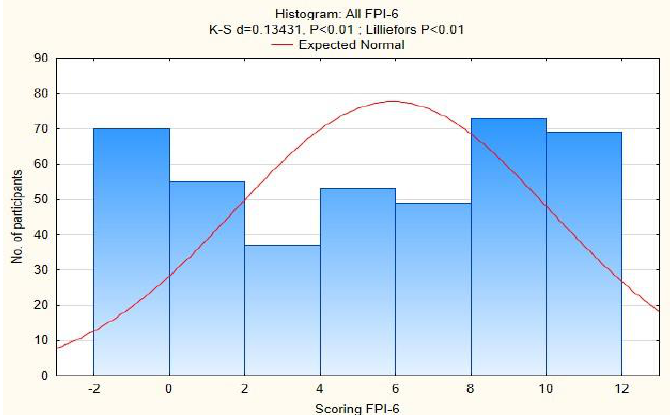
Figure 1. Histogram of all FPI-6 analyses. Right foot pronation with a score of FP I ≥ + 6 was observed in 58.6% (119, n = 203) of children, normal foot position of FPI < 6 was observed in 41.3% (84, n = 203), and supina- tion of FP I ≥ −1 was not detected in any participants. For the left foot, a normal position of FPI < 6 was observed in 42.3% (86, n = 203) of children, pronation was observed in 57.6% (117, n = 203), and supination of FP I ≥ − 1 was not detected (Figure 2). Figure 2. FPI-6 results from the right and left foot. WeeGGI gait analysis was measured during the same session as the foot postural index; patients independently walked barefoot on the hard floor for at least ten steps (Ta- ble 1). The WeeGGI mean was 6.44 ( n = 406, SD 3.84), which can be considered a deviation from the regular gait pattern. The right foot mean score was 6.41 ( n = 203, SD 3.78), and the left foot mean score was 6.47 ( n = 203, SD 3.91). The correlation for general gait analysis was r = 0.93, presenting very high impact of DDH on gait. Significant correlation was found between the right r = 0.97 and left r = 0.25 lower limbs. Gait analysis showed that DDH affects the right lower limb more than the left. The sign test revealed difference be- tween the right and left lower limbs with a p -value of 0.88 ( p < 0.05). DDH affects the left lower limb more than the right during gait (Figure 3).